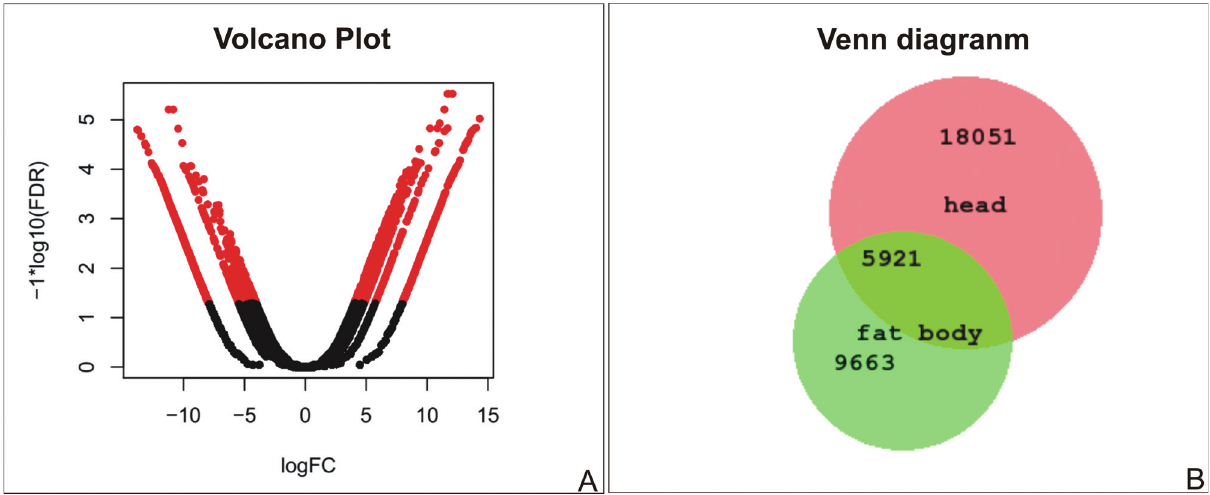
Figure 3 - Comparison among head and fat body transcripts. (A) Volcano plot of differentially expressed transcripts; the X-axis displays the fold change expression differences (FC) and the Y-axis the statistical significance based on a false discovery rate (FDR) cut-off of 0.001. (B) Venn diagram of blastx results of transcripts detected in the head and fat body.